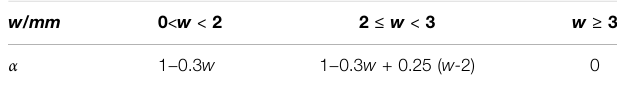
TABLE 3 | The damage coef fi cient of the RC column subjected to axial compression corrosion.